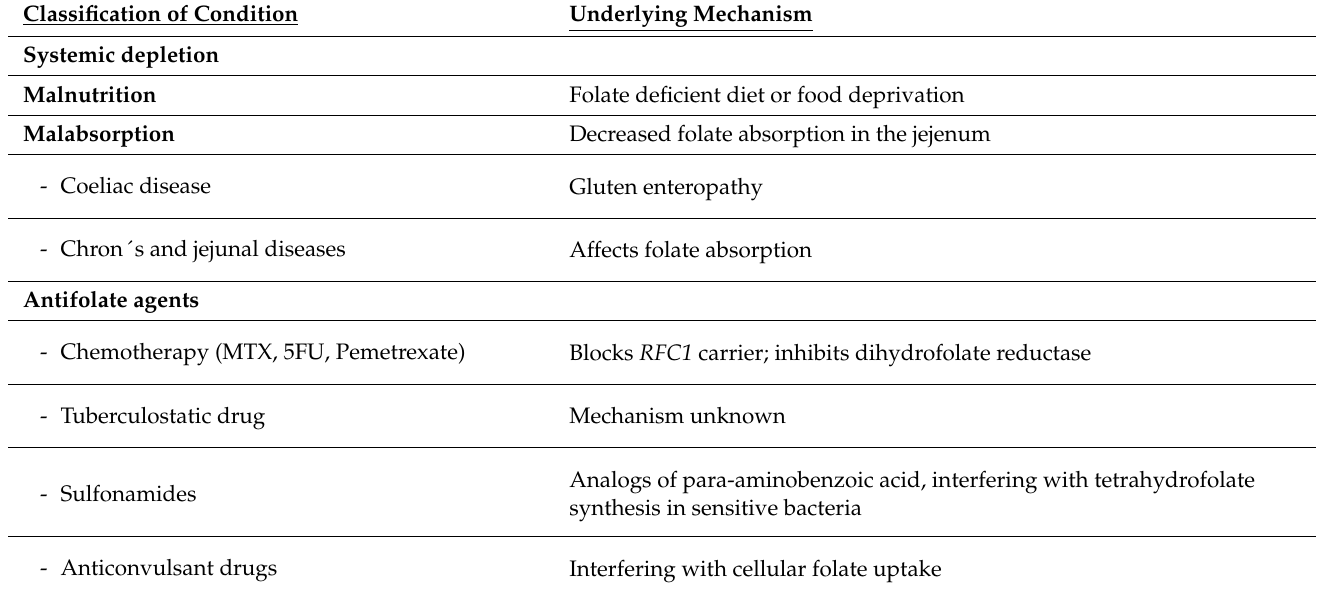
Table 2. Overview of systemic folate depletion and conditions of CFD associated with isolated 5MTHF loss in the